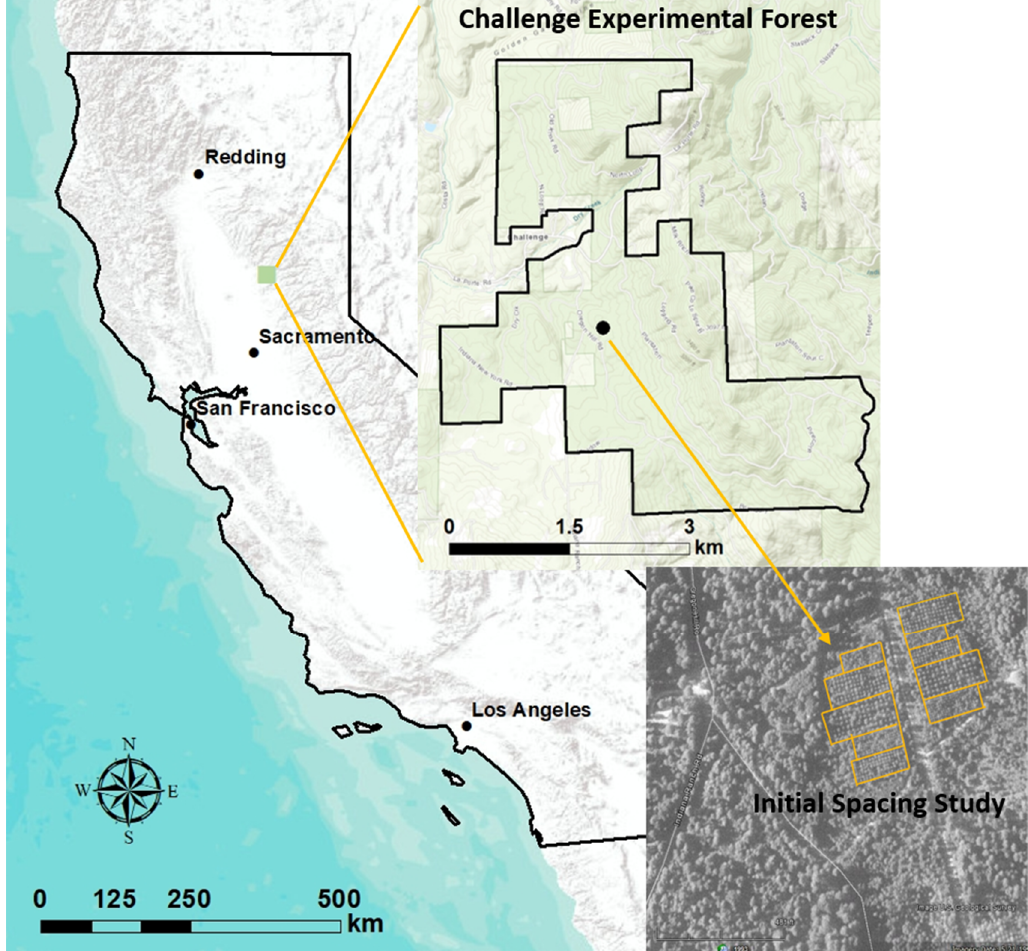
Figure 1. Map of California, Challenge Experimental Forest, and Initial Spacing Study plot layout.